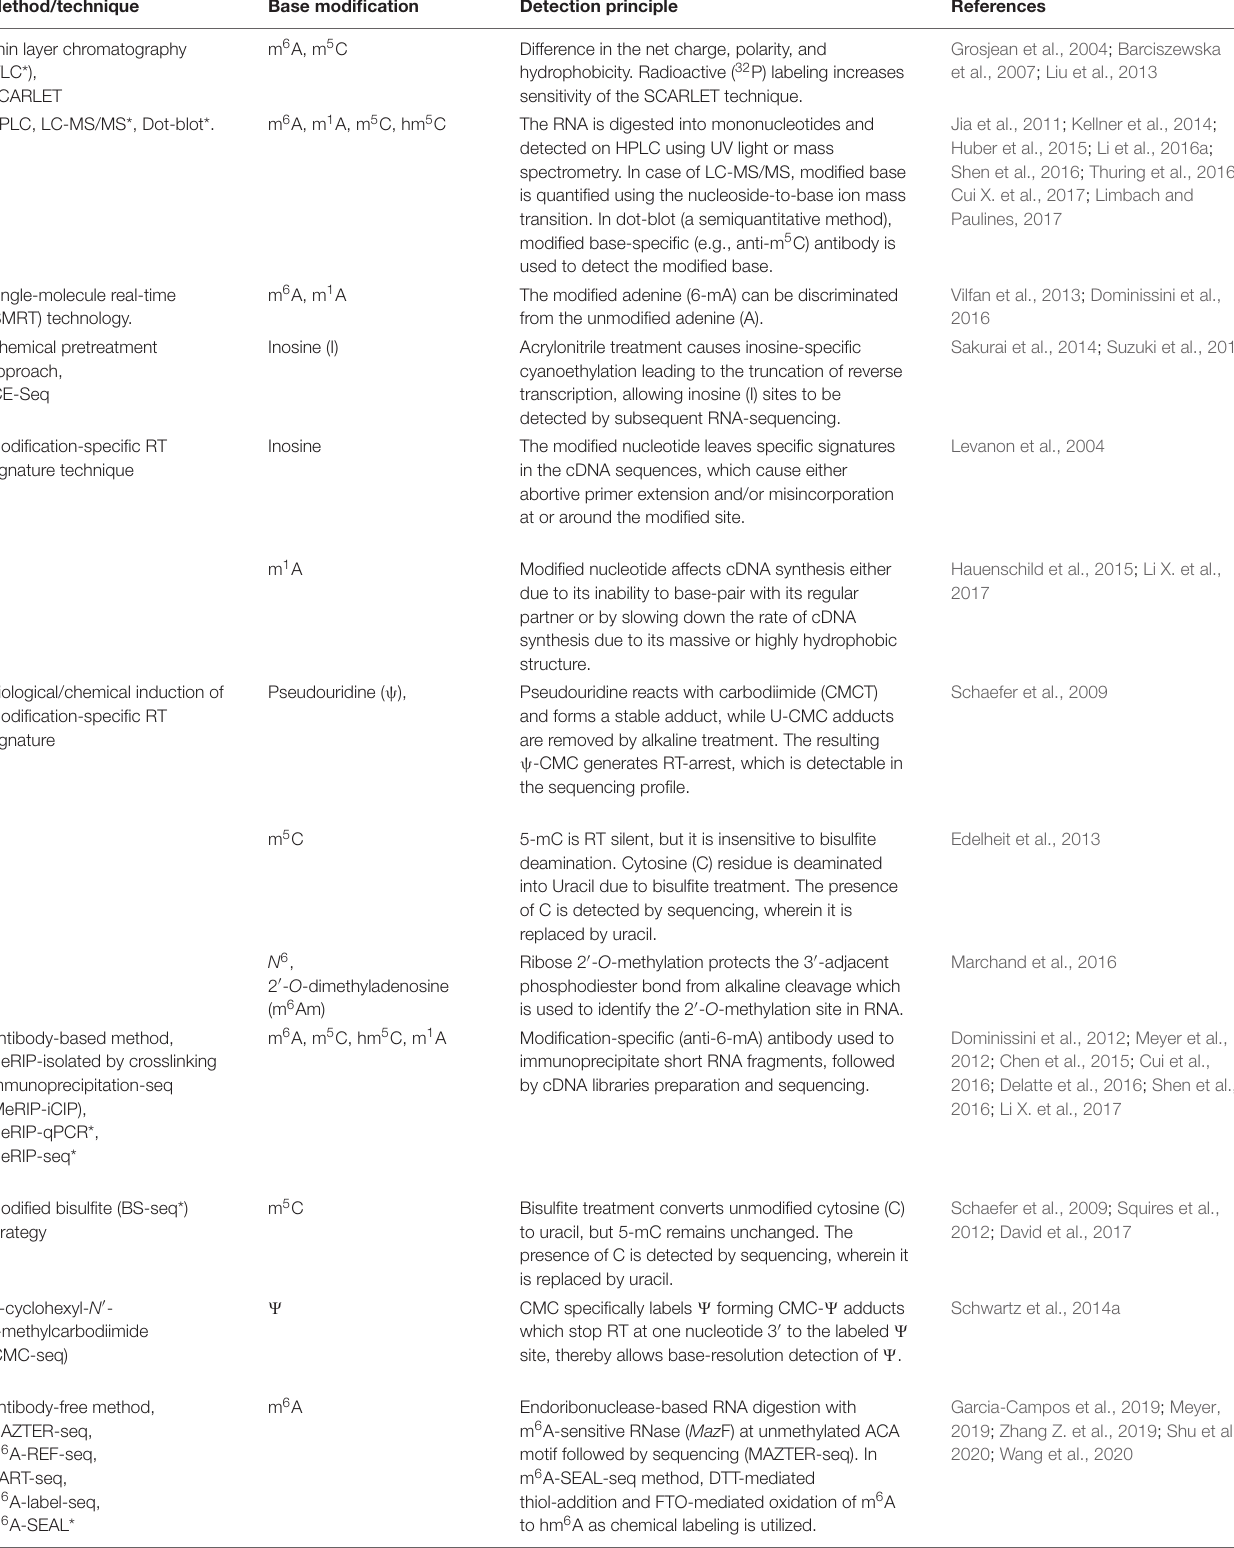
TABLE 2 | Techniques for detection of modified RNA